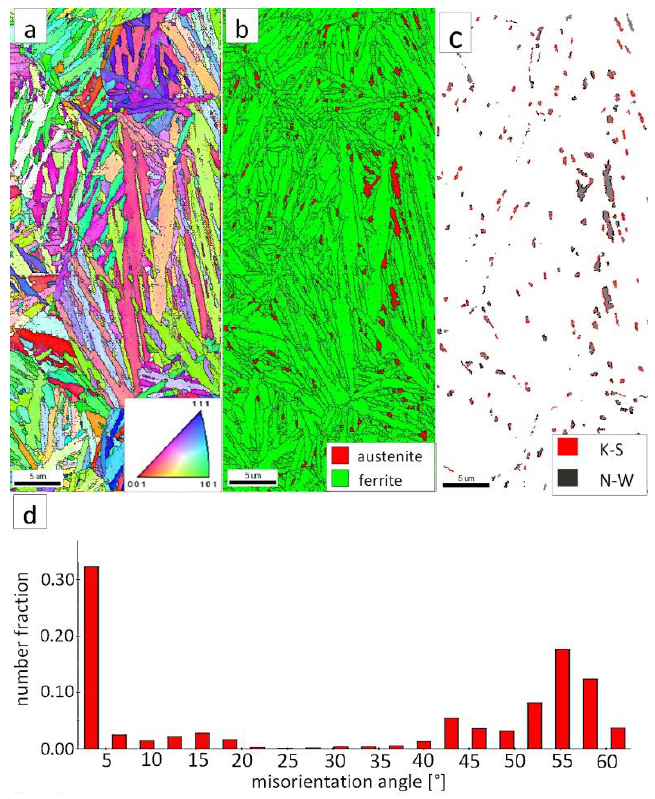
Figure 21. ( a ) IPF map of the BM. ( b ) Phase distribution map of the BM. ( c ) Phase distribution map with indicated boundaries of N-W (marked in red) and K-S (marked in blue) orientations. Ferrite-white, austenite-gray. ( d ) Misorientation angles distribution of the BM.